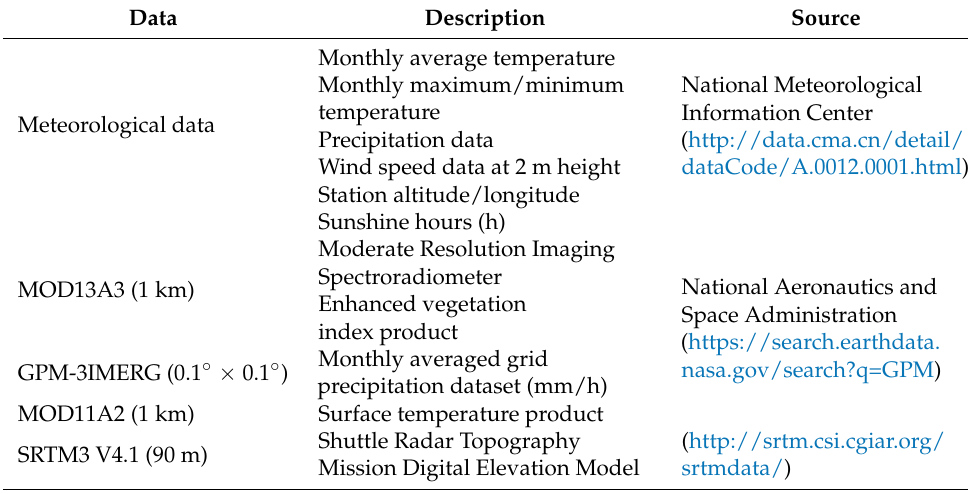
Table 1. Data description and sources.